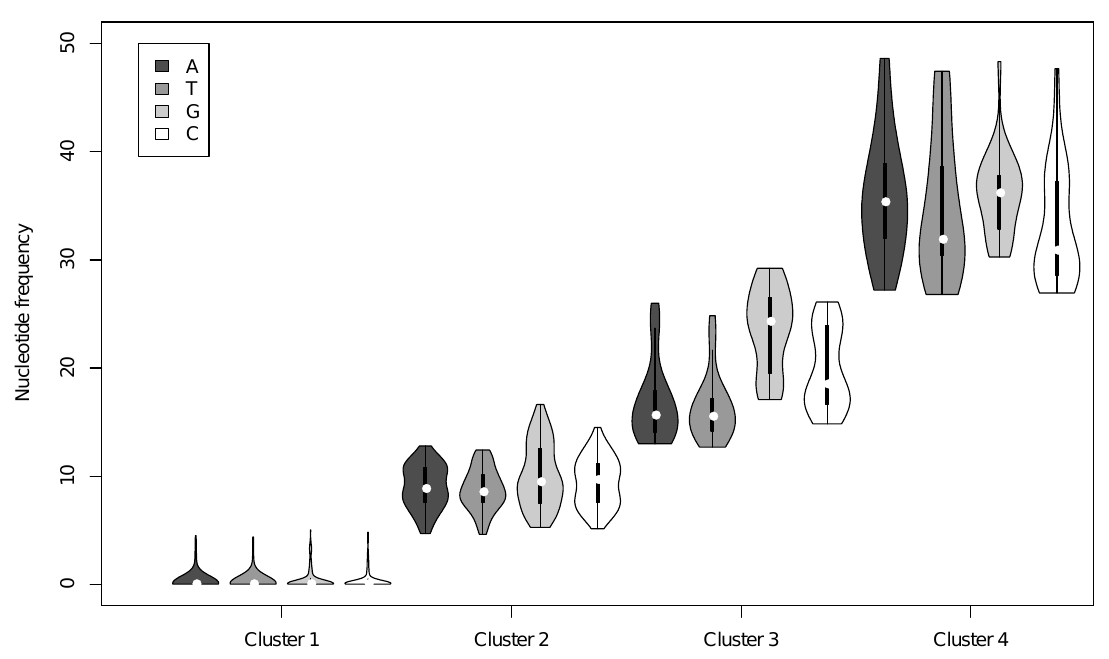
Figure 4. Frequency of K-means clusters. For each violin plot, the white dot represents the median, the black bar limits represent the 1st and 3rd quartile (respectively the lower and the upper limit of the bar). The shapes of the violins represent the probability density of the nucleotides in the cluster for the different percentages. The color of the shading represents the nucleotide as shown in the legend (always in the order A: Adenine, T: Thymine, G: Guanine, C: Cytosine).